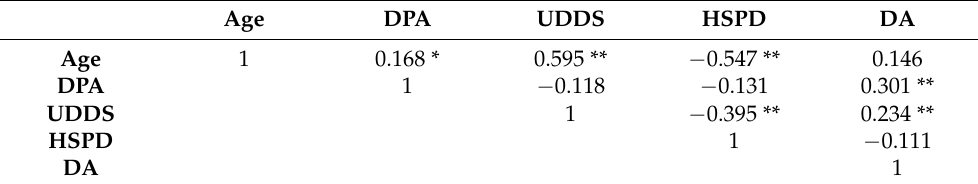
Table 6. The correlation of healthy, everyday behaviours and ages of the